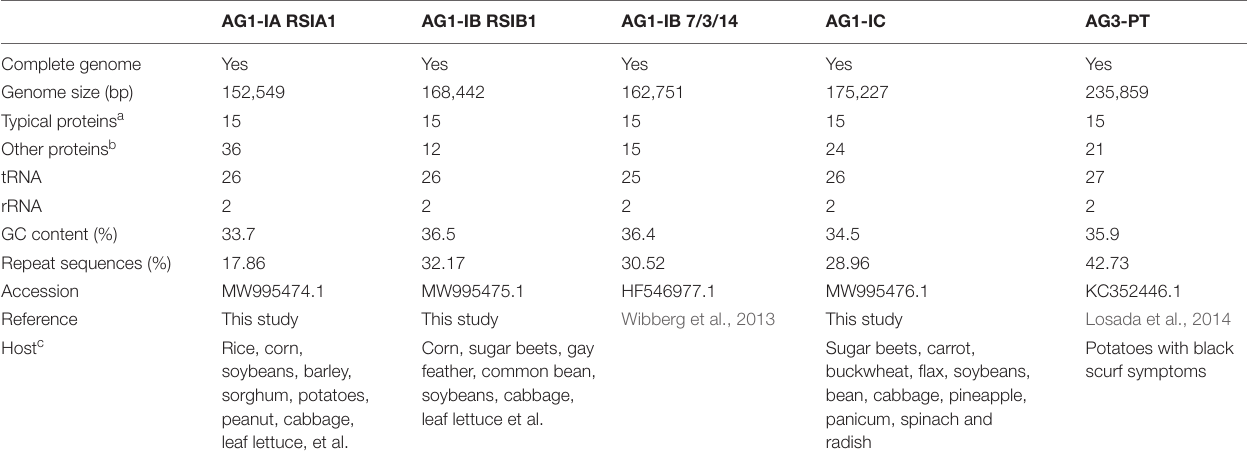
TABLE 1 | Statistics of mitochondrial genomes of Rhizoctonia solani